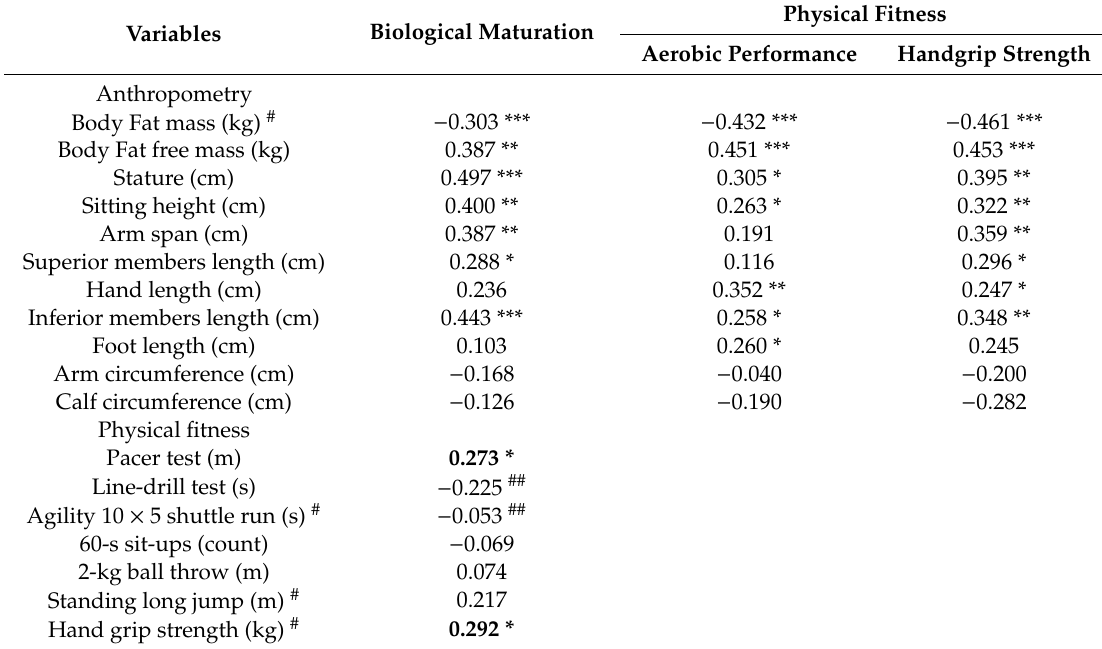
Table 2. Partial correlation coe ffi cients (controlling for chronological age and body mass) among biological maturity (given by the z-score of the attained %PMS), anthropometric, and physical variables; and partial correlation coe ffi cients between aerobic performance and handgrip strength with anthropometric variables ( n =